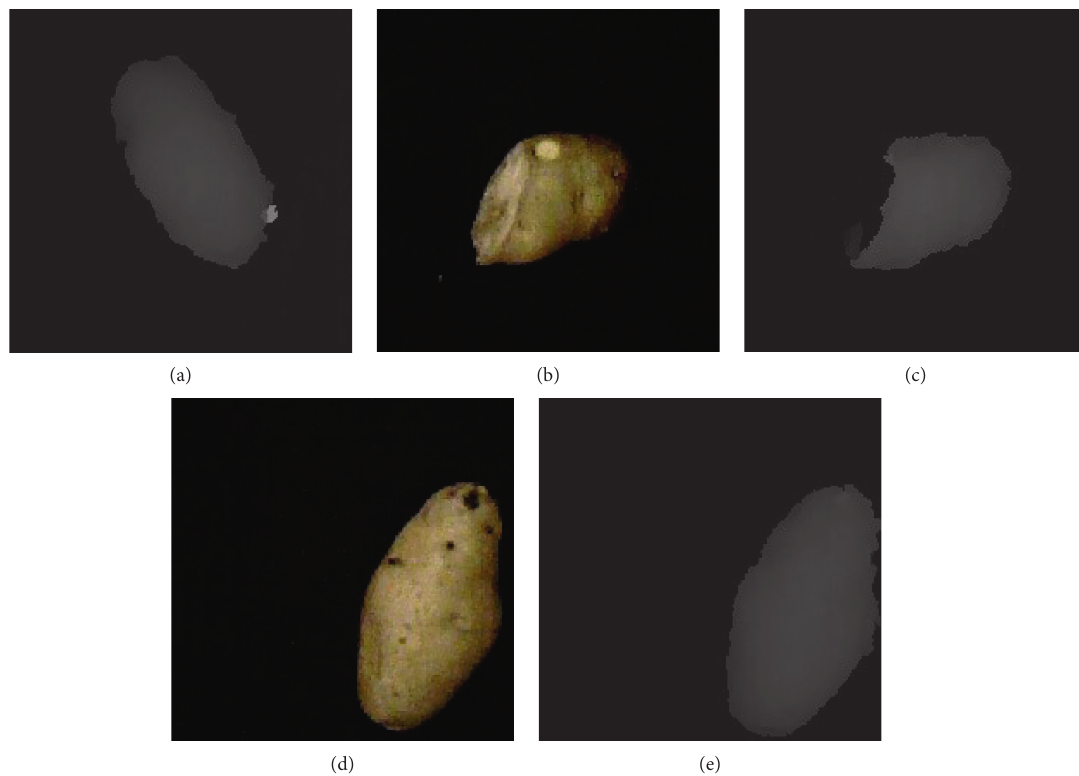
Figure 10: Mistake grading samples by the CNN model. (a) Unexpected noise. (b) Color image of machinery injury potato. (c) Depth image of machinery injury potato. (d) Color image of sprout potato. (e) Depth image of sprout